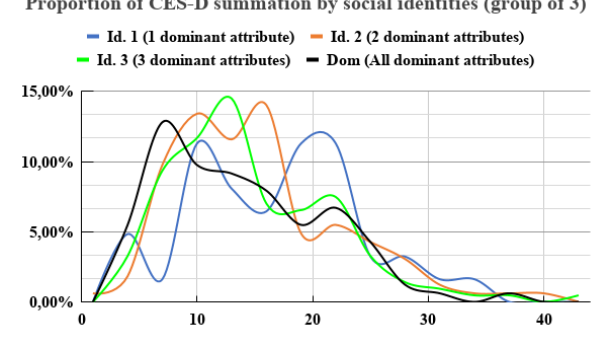
Figure 5 : CES-D linear graph by social identity (groups of 3)